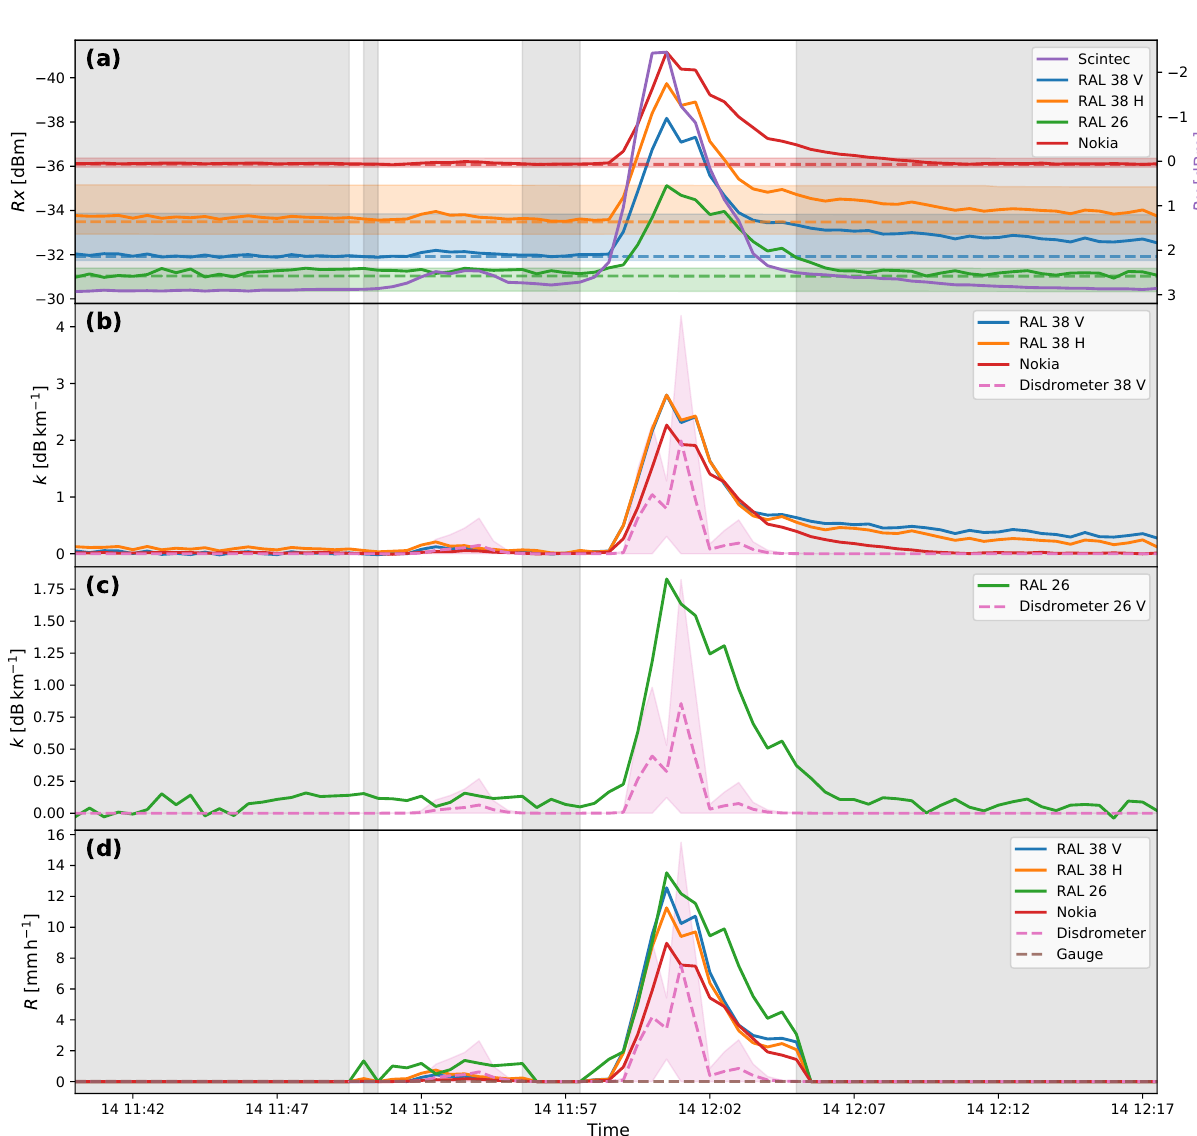
Figure 5. Time series of an event on 14 July 2015. (a) Received power levels (solid lines) and reference levels (median over dry periods in a 24h moving window: dashed lines). The 5th and 95th percentile power level over dry periods in a 24h moving window are indicated by the coloured shading. (b) Specific attenuation of the 38GHz links derived using the reference levels as well as the theoretical specific attenuation at 38GHz derived from the disdrometers. Both the weighted spatial average (dashed line) and weighted spatial standard deviation (shaded area) are shown. Panel (c) is the same as (b) , but for 26GHz. (d) Rainfall intensities derived from the link attenuations using the R – k power law and rainfall intensities derived from the disdrometers. Both the weighted spatial average (dashed line) and weighted spatial standard deviation (shaded area) are indicated. The rainfall intensities derived from the tipping bucket gauge are indicated with the brown dashed line. Dry periods, as determined with the disdrometers, are represented by grey shaded